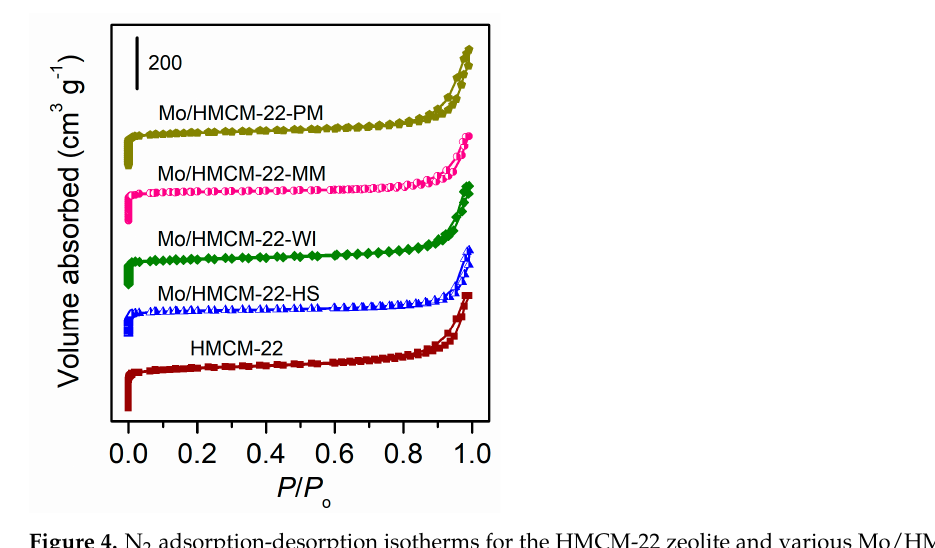
Figure 4. N 2 adsorption-desorption isotherms for the HMCM-22 zeolite and various Mo/HMCM-22 catalysts.